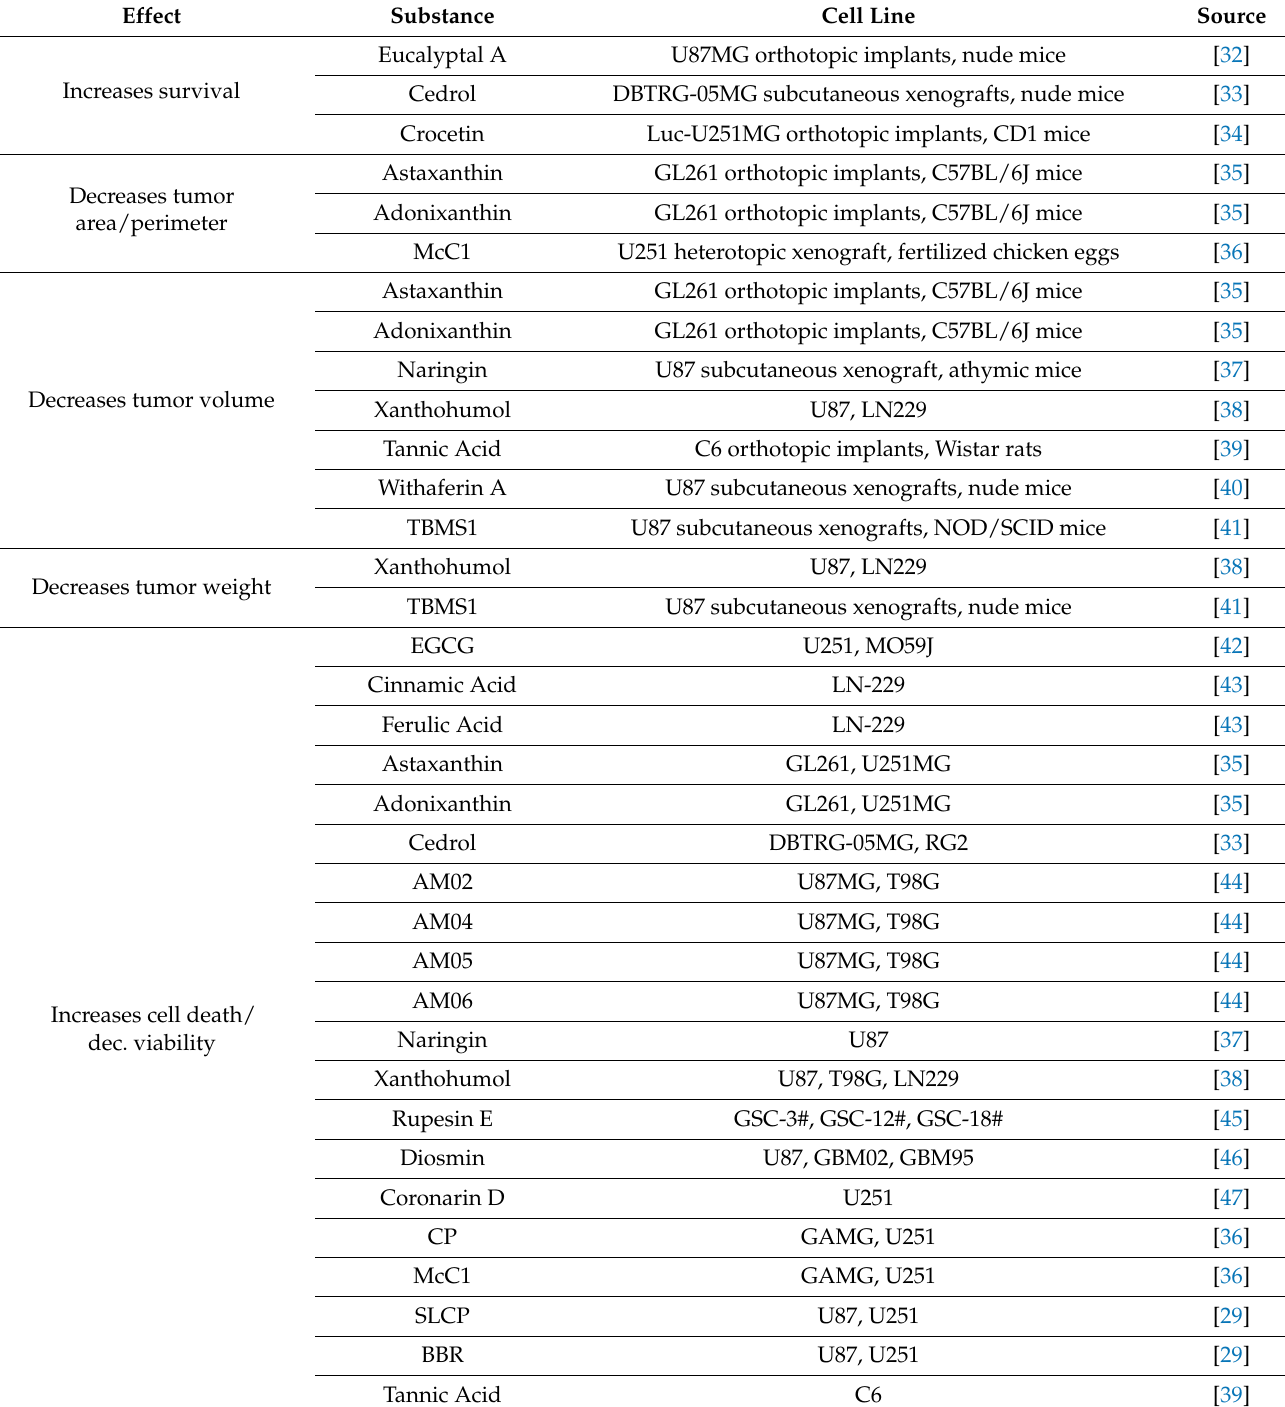
Table 2. Generalized downstream effects of natural compounds on GBM. Many of the reviewed substances exert measurable cytotoxic effects in vitro. Moreover, several substances reduce tumor size and improve survival in-animal models of